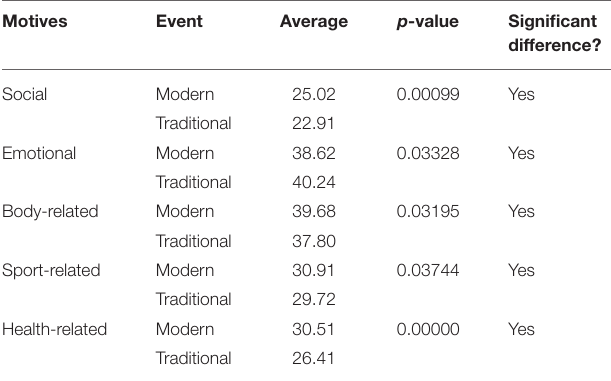
TABLE 10 | Average values for the sum of ratings of individual motives, broken down into participants taking part in traditional and modern events. Motives